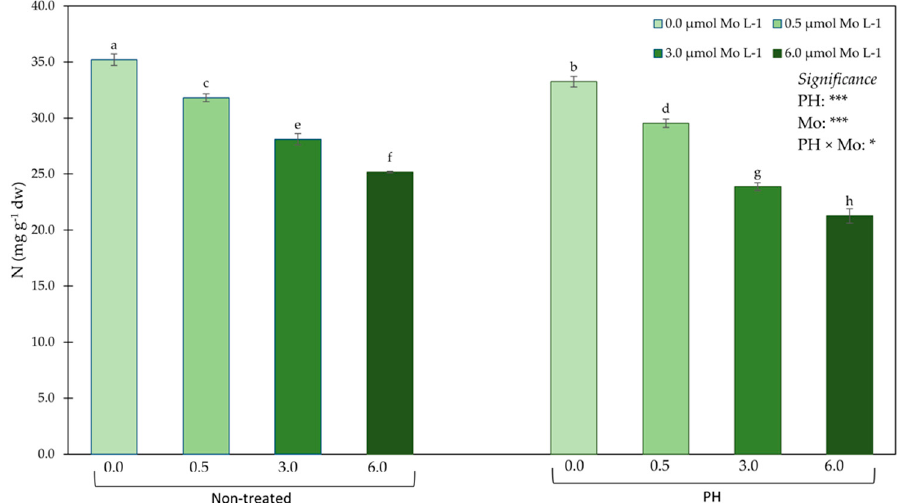
Values in a column followed by different letters are significantly different at p ≤ 0.05. NS, *** non-significant or significant at 0.001, respectively. ANOVA and mean separation for plant N concentration showed a significant interac- tion PHs × Mo (Figure 2).